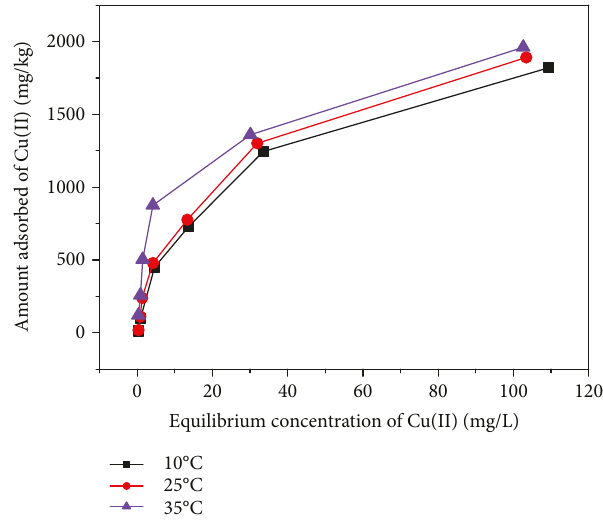
Figure 5: E ff ect of temperature on adsorption.